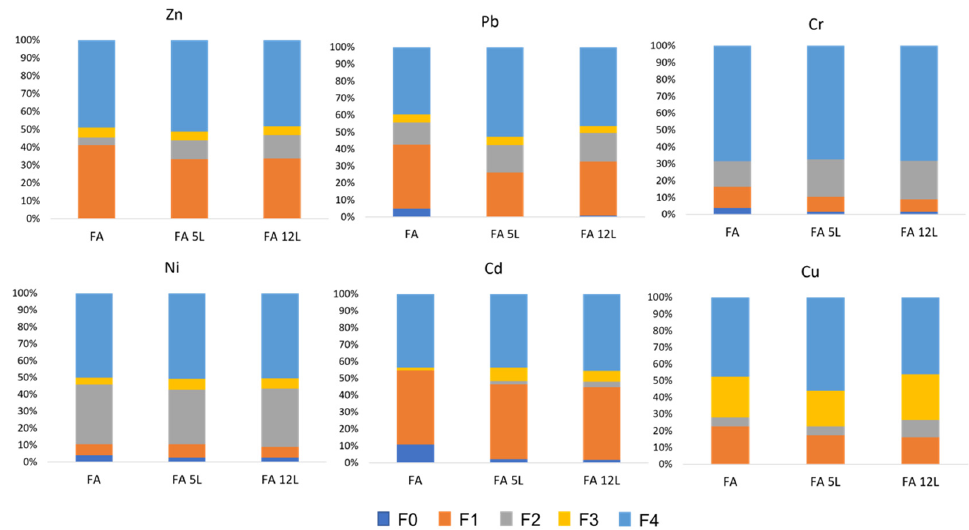
Figure 7. Speciation distribution of the main heavy metals for pristine FA and FA that